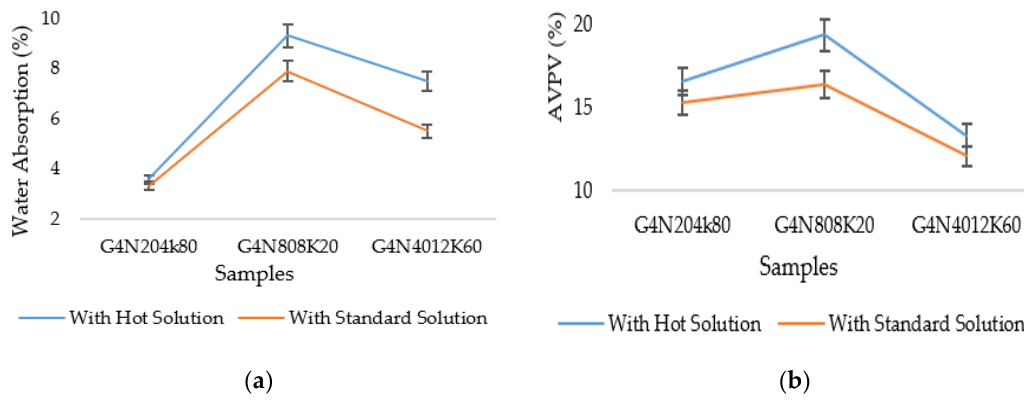
Figure 17. ( a ) Water absorption and ( b ) AVPV of geopolymer cement paste samples at 28